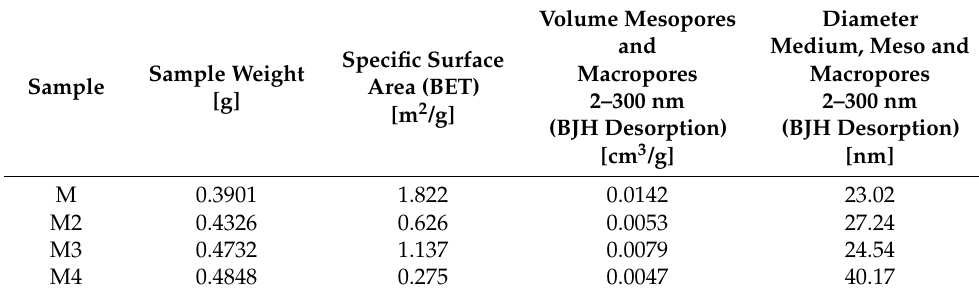
Table 2. The main surface and porosity characteristics of the analyzed material.